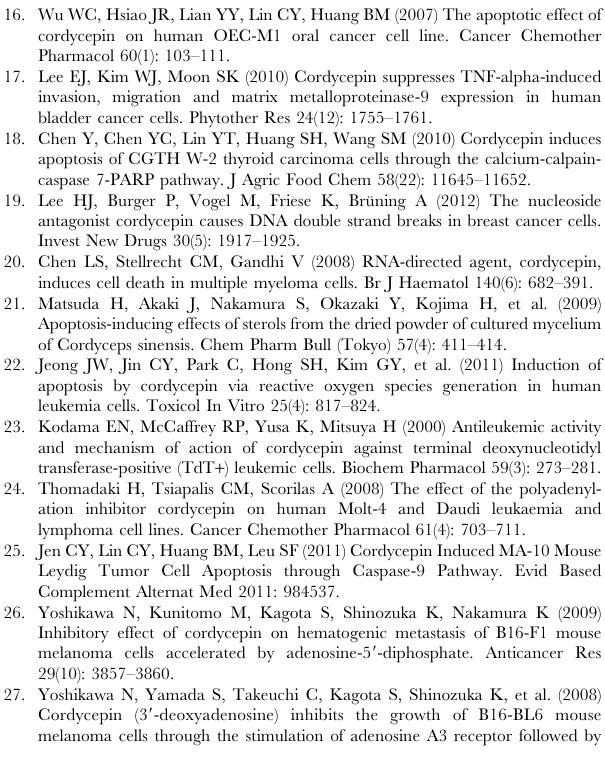
Figure S1 Effects of adenosine on cell proliferation. A549, U937 and K562 cells were treated with different concentrations of cordycepin and adenosine (50 to 200 m M) for 24 and 48 hrs. Cell proliferation was determined by an MTT assay. These data are from three independent experiments. Each bar denotes mean 6 S.E.M. (TIF) Figure S2 Effect of adenosine on b -catenin expression. U937, K562 and A549 cells were treated with cordycepin (100 m M) or adenosine (50 to 200 m M) for 4 hrs and the expression of b -catenin was determined by Western blot analysis. Actin was used as a loading control. (TIF) Figure S3 Efect of cordycepin on cyclin D expression. A549 and U937 cells were treated with 100 m M cordycepin for 2 or 4 hrs. The expression of b -catenin and cyclin D1 was determined by Western blot analysis. Actin was used as a loading control.